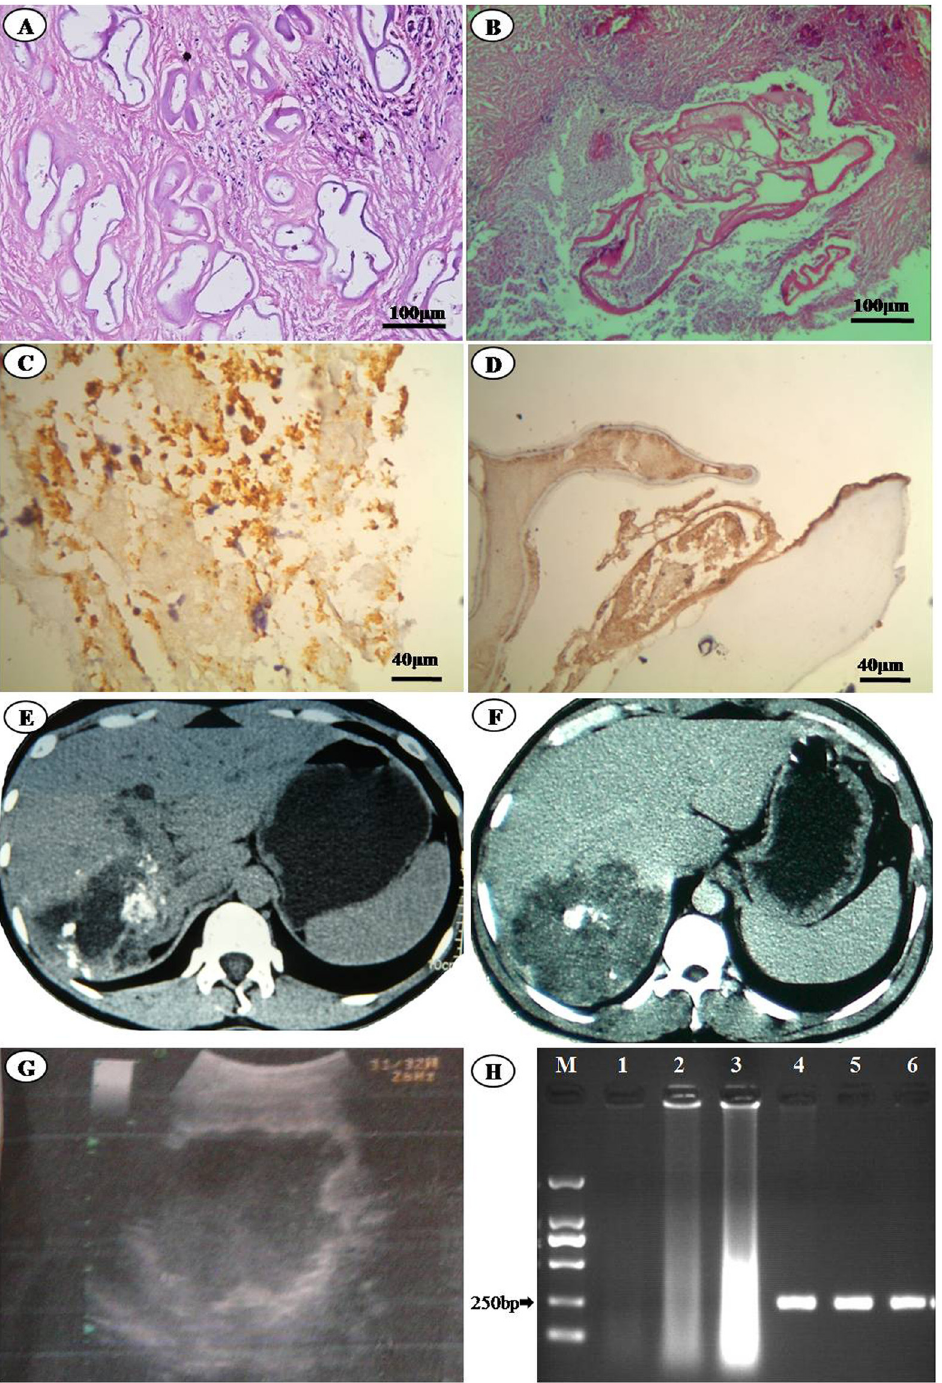
Fig 2. The methods used in AE diagnosis. (A) and (B) the 5 th and 4 th cases ’ liver samples histopathological images (HE staining, ×100); (C) and (D) the 7 th and 8 th cases ’ liver samples immunohistochemical staining images (×400); (E) and (F) the 7 th and 8 th cases ’ abdominal CT images; (G) the 1 st cases ’ abdominal B-ultrasound images; (H) DNA extracted from three cases ’ paraffin- embedded samples and PCR products (M.5000 bp DNA Marker. Line 1, 2, 3, DNA extracted from the 5 th , 7 th , and 8 th cases paraffin-embedded samples. Line 4, 5, 6, PCR products of the 5 th , 7 th , and 8 th cases ’ DNA samples).